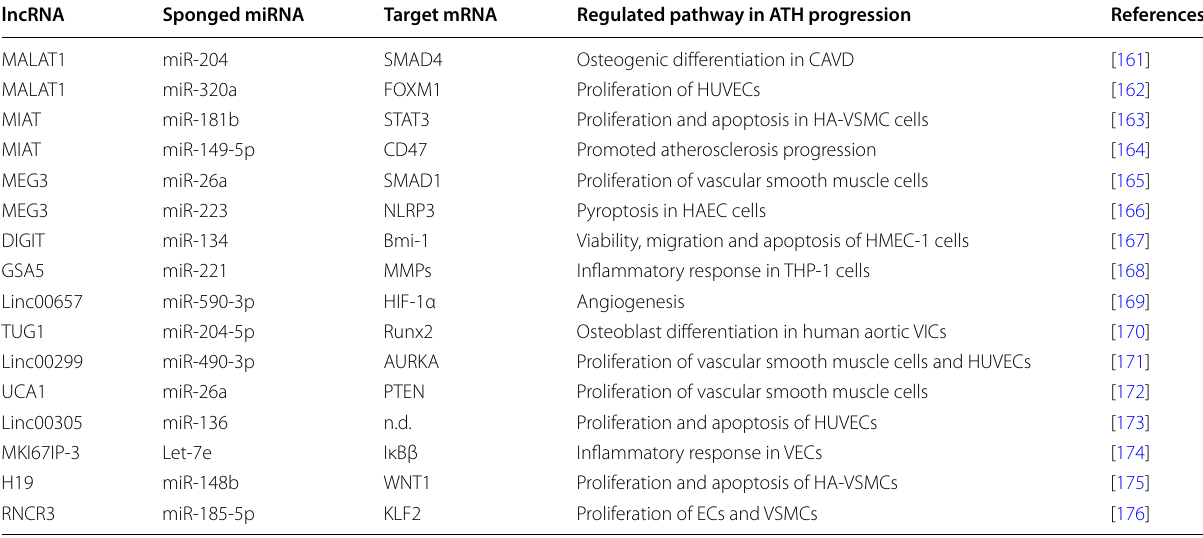
For each lncRNA shown are also a sponged miRNA and one mRNA target of this last, as well as the effect of the RNA network on ATH progression. n.d. not